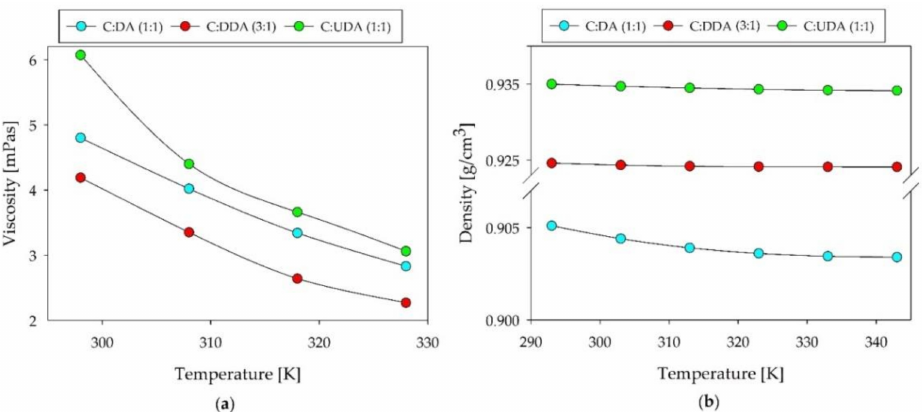
Figure 8. ( a ) Viscosity and ( b ) density of the new